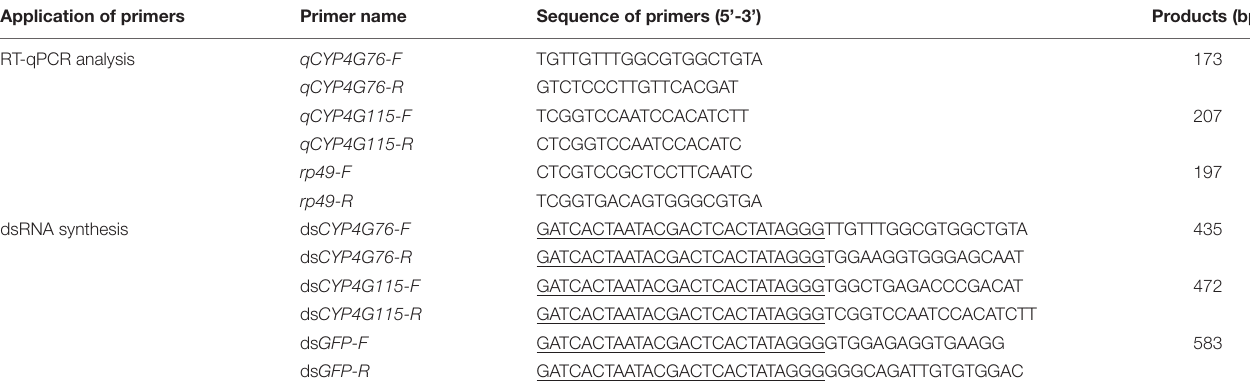
TABLE 1 | Primers used for PCR amplification, in RT-qPCR analysis and dsRNA